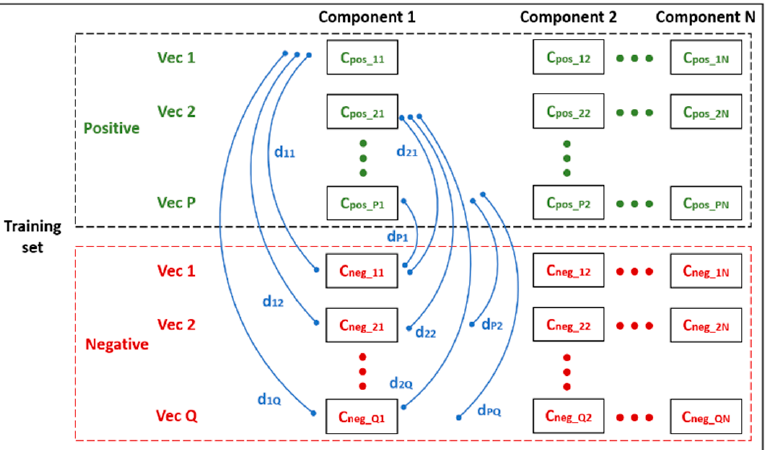
Figure 2. An illustration of the first stage of the proposed mechanism for a binary sentiment analysis scenario. The value of each component from each feature vector is compared with the values of the same component from all the feature vectors of the other classes to make the similarity measurements. The component values are then replaced in descending order of total distance measurements for each value. The new feature vectors are then formed from these reordered values.